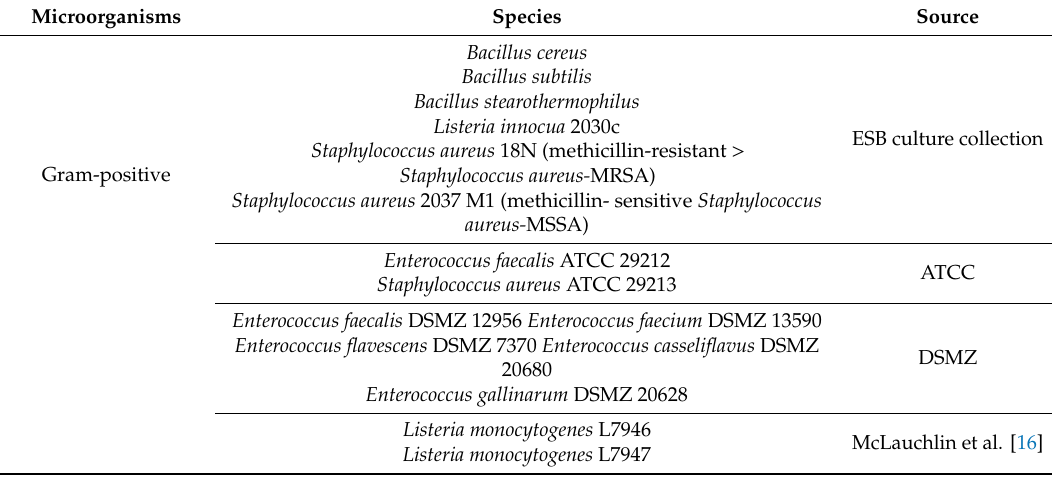
Table 1. Microbial strains used in this